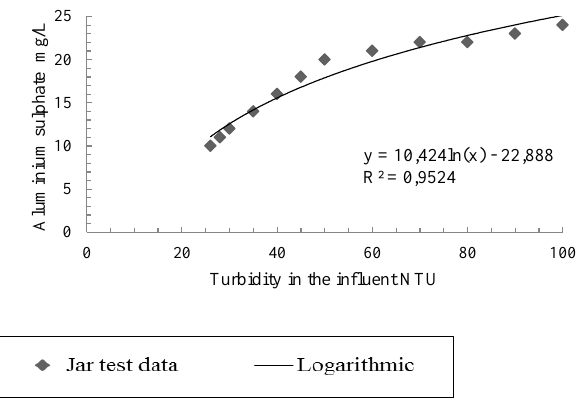
Figure 3. Aluminium sulphate dose as a function of influent turbidity in CF-UGF Unit.